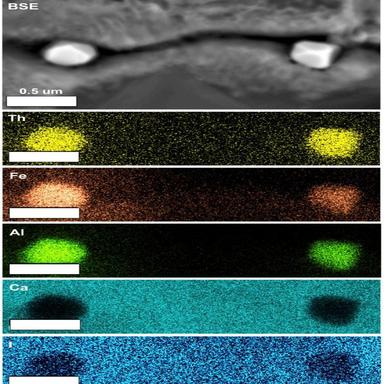
Image and elemental X-ray maps of two other high contrast, Th-rich nanoparticles.